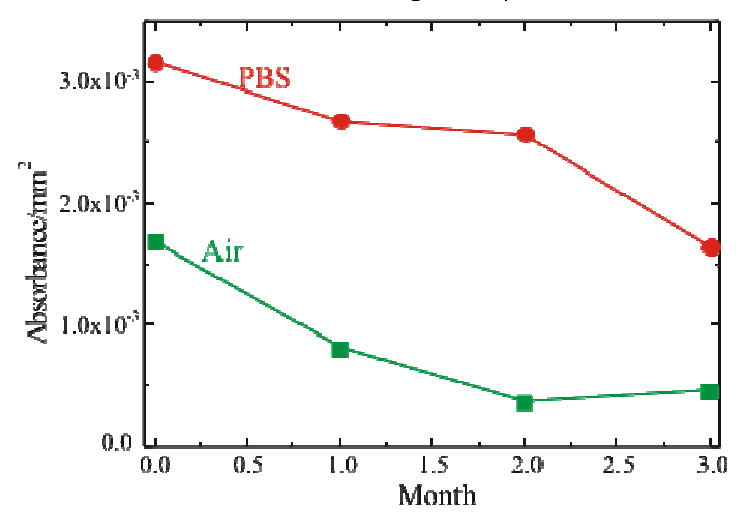
Figure 5. Glucose oxidase activity as a function of storage time for bulk SiO stored in PBS at 4°C (red dots) and in air at RT (green